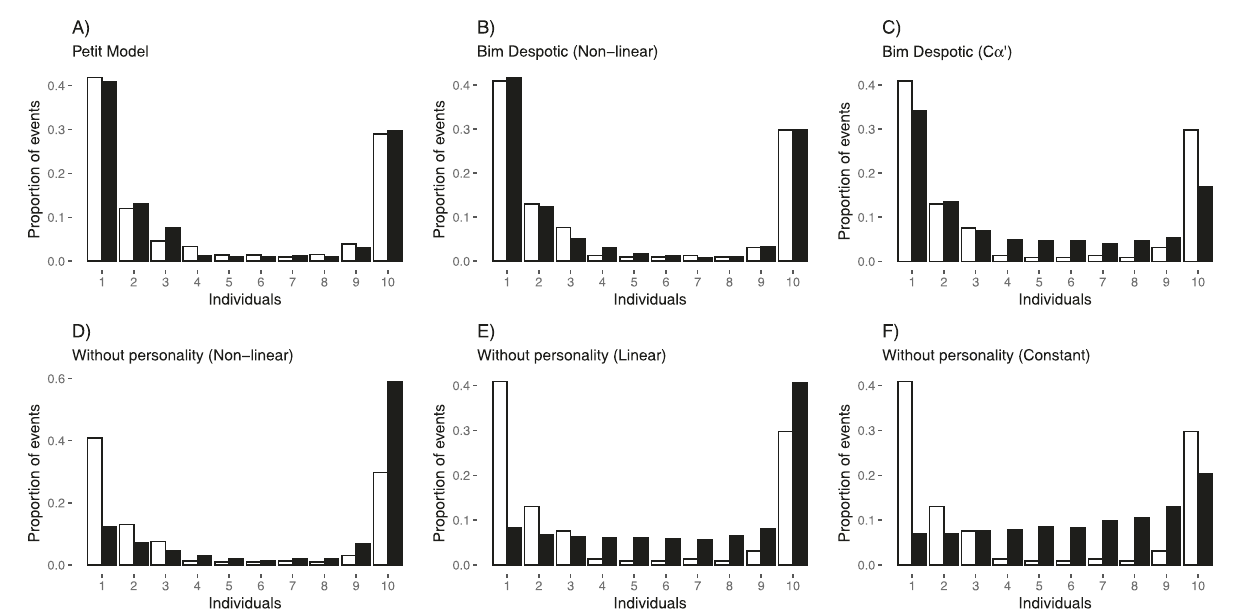
Fig. 7 Distributions of individuals involved in each initiation for key simulations. Comparison of distributions of individuals involved in each initiation for key simulations (black bars) versus fi eld data of Capuchin monkeys (white bars 10 ). A corresponds to the Petit model, including feedback on P C and P J ; B Bim – despotic scenario, with non-linear feedback, ratio of 5:5 leaders:followers and mean of the highest α ’ distribution of 3160; C Bim – despotic scenario, with C α ’ cancellation rate, ratio of 6:4 leaders:followers and mean of the highest α ’ distribution of 960. Scenarios without personality are depicted with D non-linear, E linear and F constant